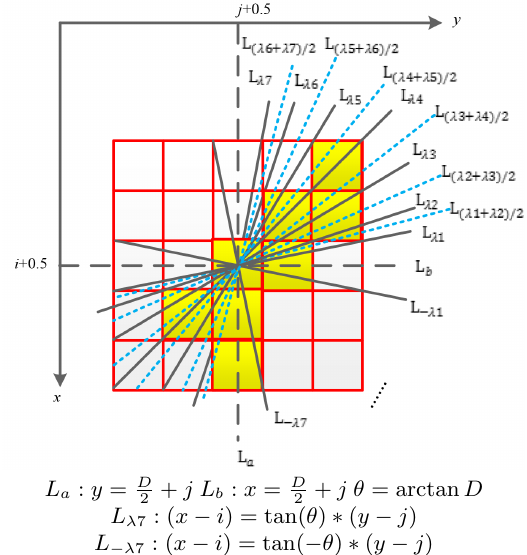
Figure 2. Sketch map of the linear subpixel feature detection for class c in p ij